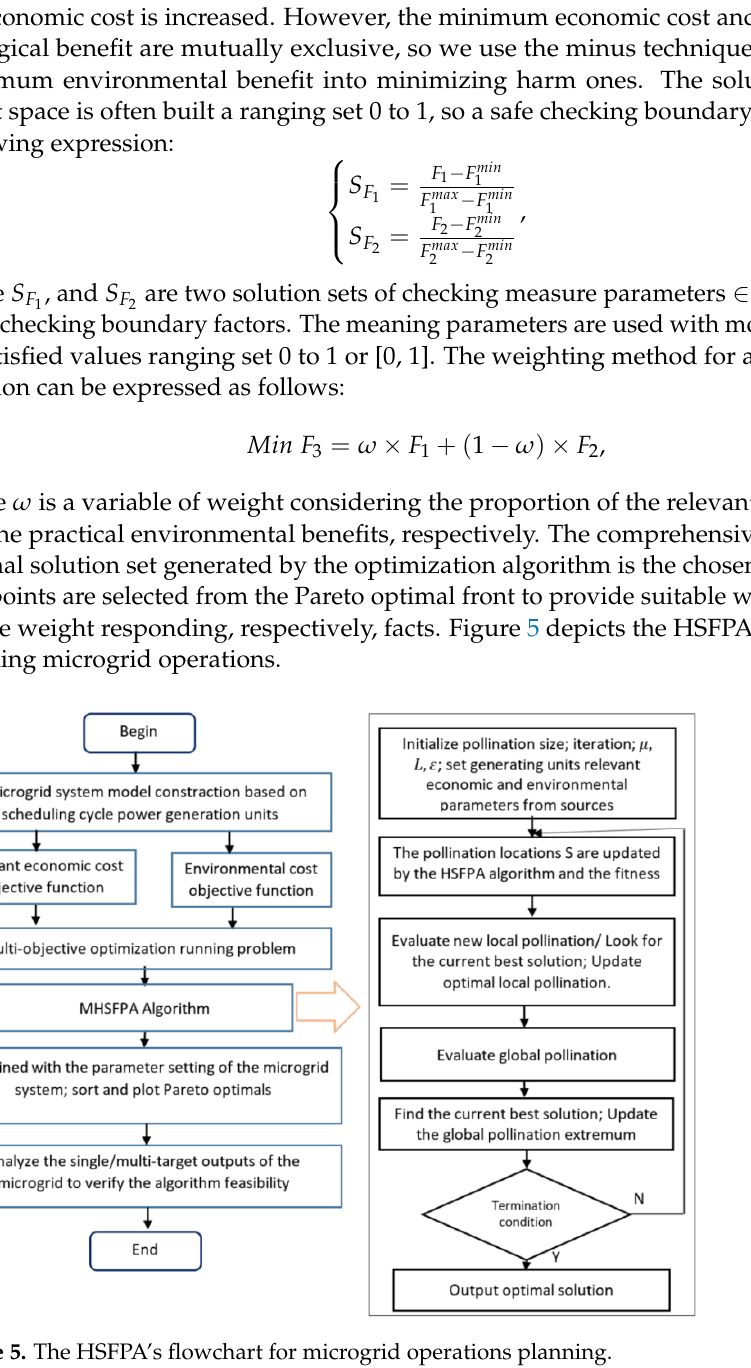
Figure 5. The HSFPA ’ s flowchart for microgrid operations